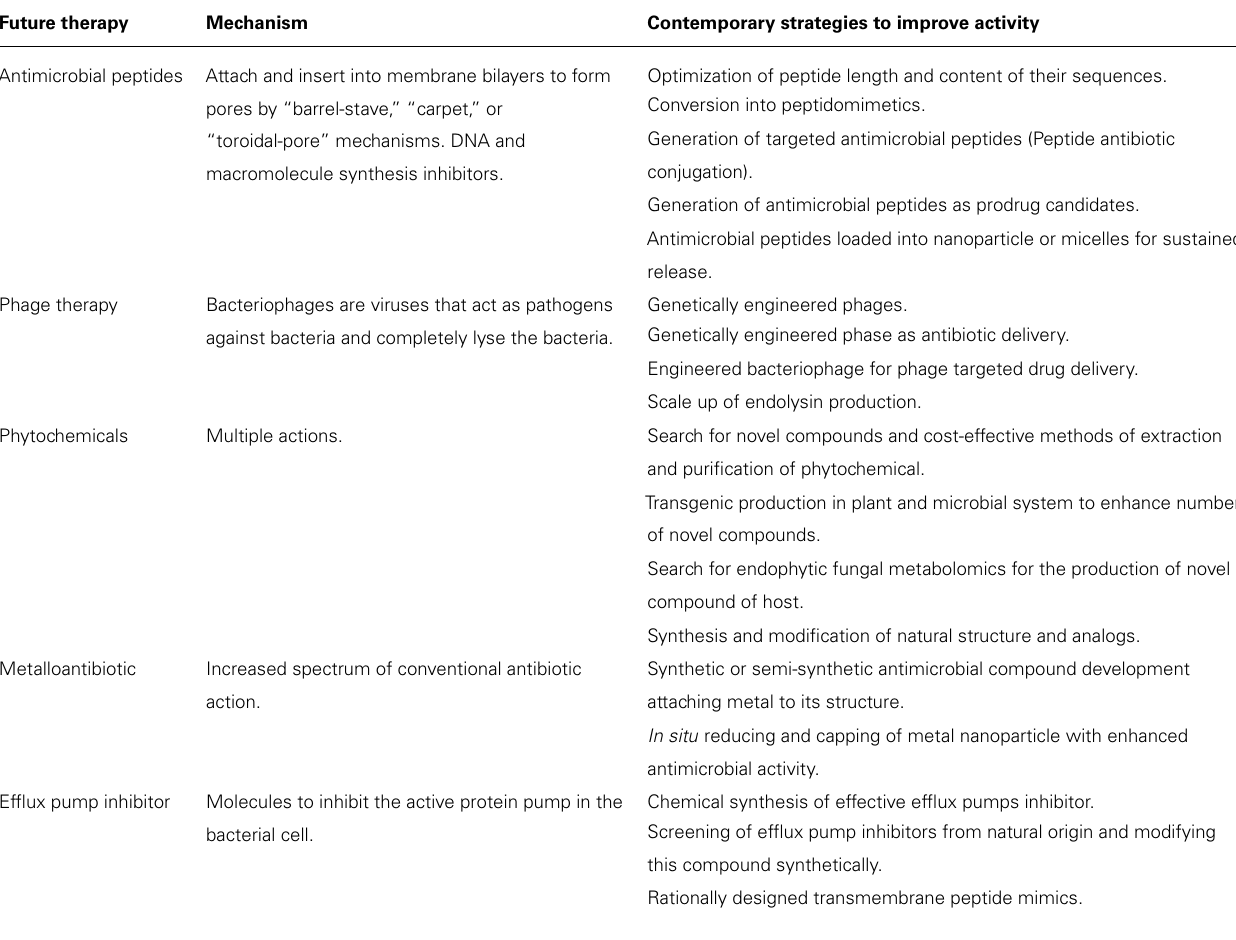
Table 1 | Major types of antimicrobial compounds with their mechanisms of